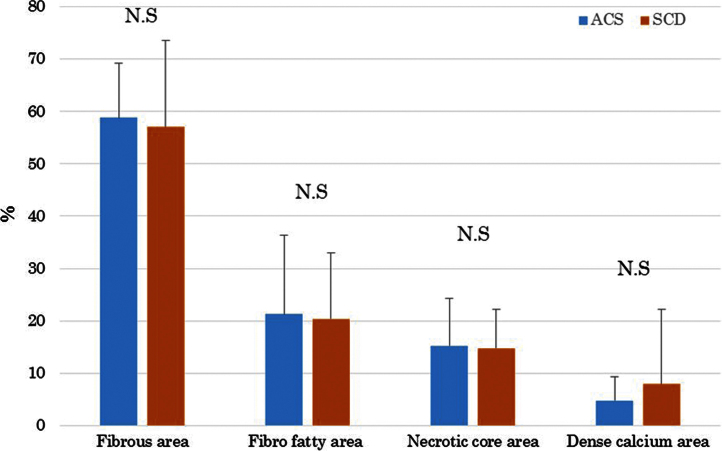
Comparisons of the percentages of the four examined component areas within plaque areas determined by VH-IVUS between ACS and SCD patients. N.S., not significant.